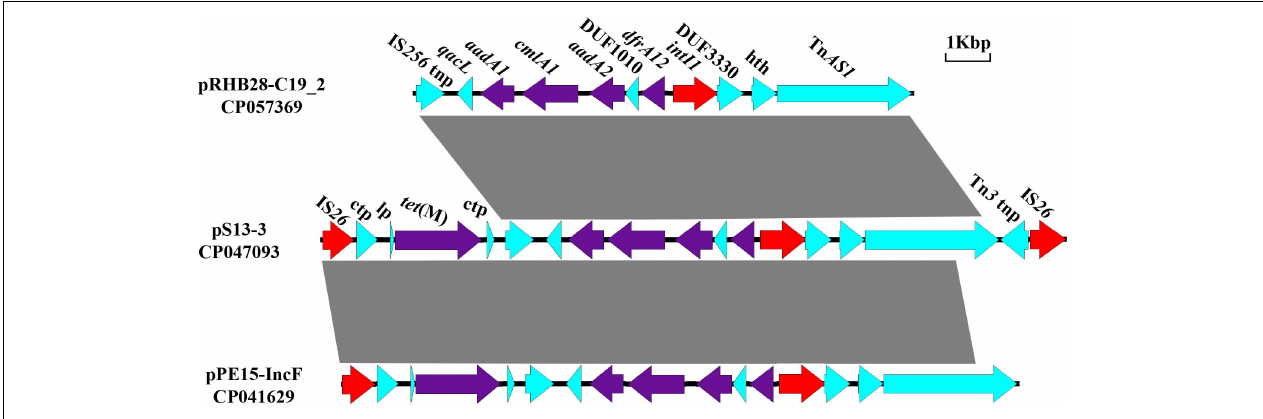
FIGURE 2 | Comparisons of the genetic environment of Tn 6942 harboring tet (M) in CP047093, with two other sequences retrieved from the GenBank database. Similar regions are indicated by dotted lines (lp, gene encoding tet (M) leader peptide; tnp, transposage; hth, helix-turn-helix domain-containing protein).